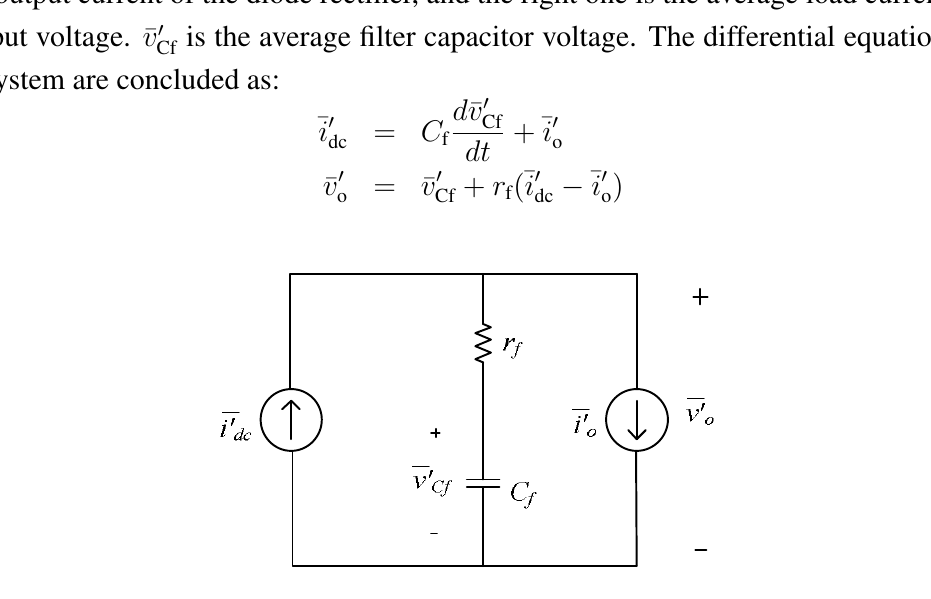
Figure 5. Equivalent circuit of the dc